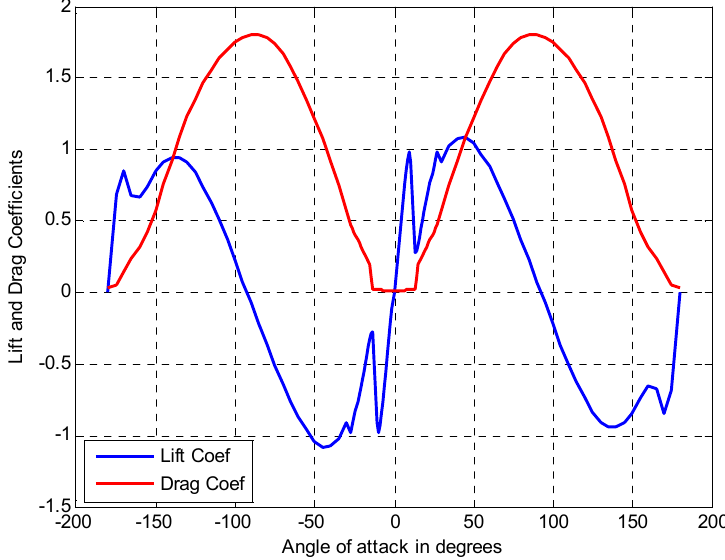
Figure 9. Lift and drag coefficients variations as a function of the angle of attack for a NACA0012 blade